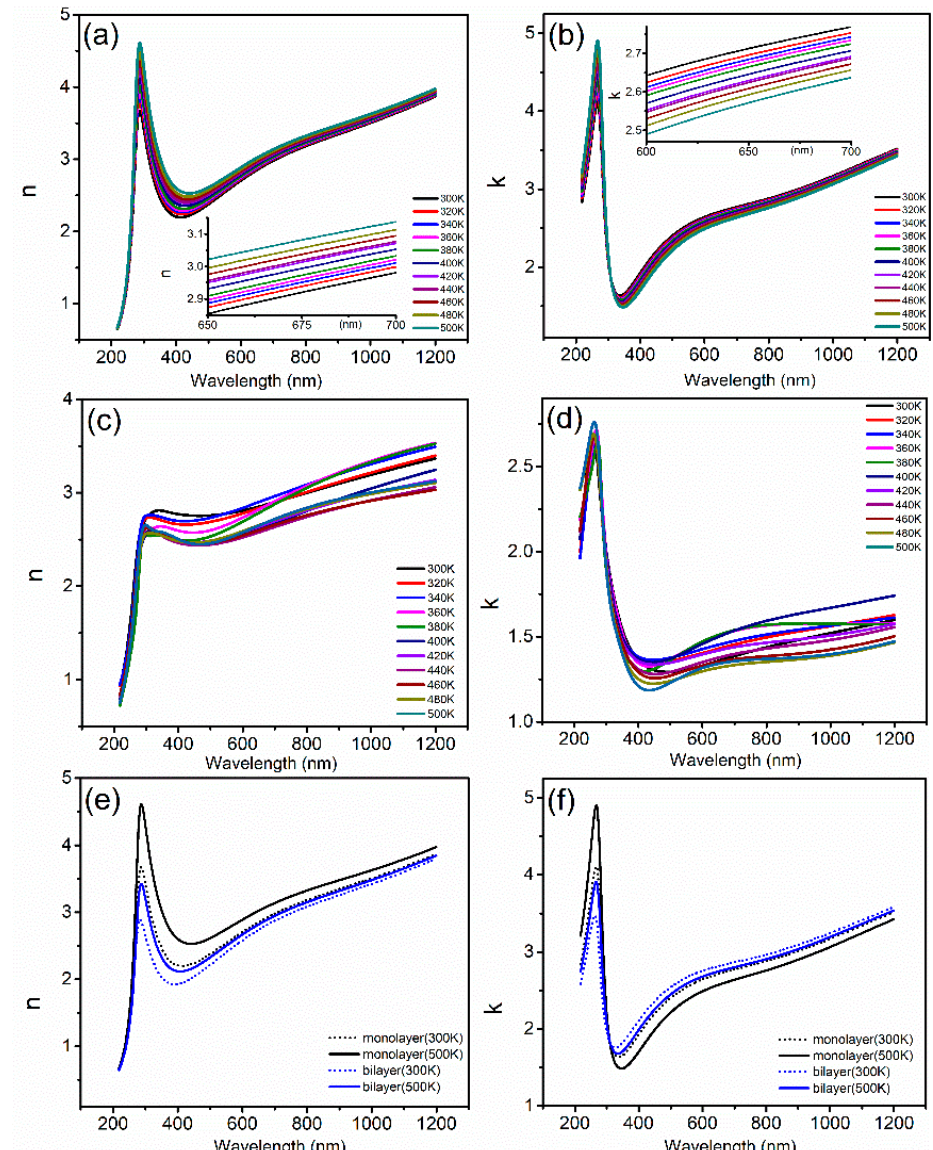
Figure 5. Temperature-dependent optical constants of graphene on Si substrate [( a ) and ( b )] and on SiO 2 /Si substrate [( c ) and ( d )] from 300 K to 500 K with a step of 20 K. [( e ) and ( f )] optical constants of four graphene samples on Si at 300 K and at 500 K.